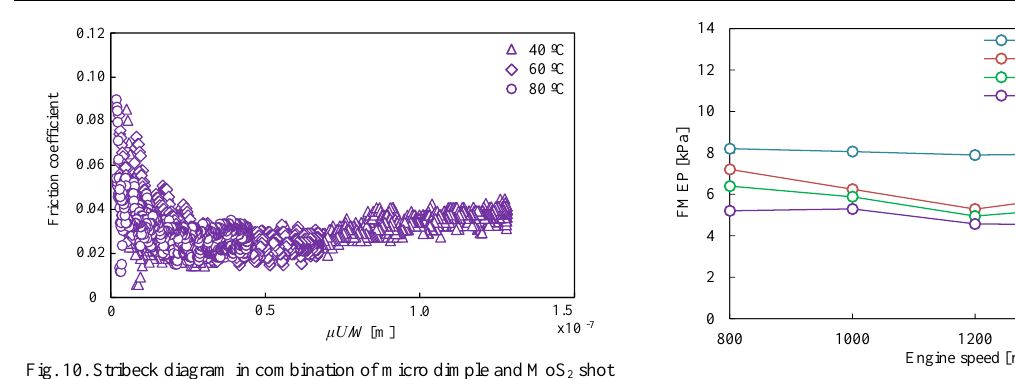
Fig. 13. FMEP at 80°C